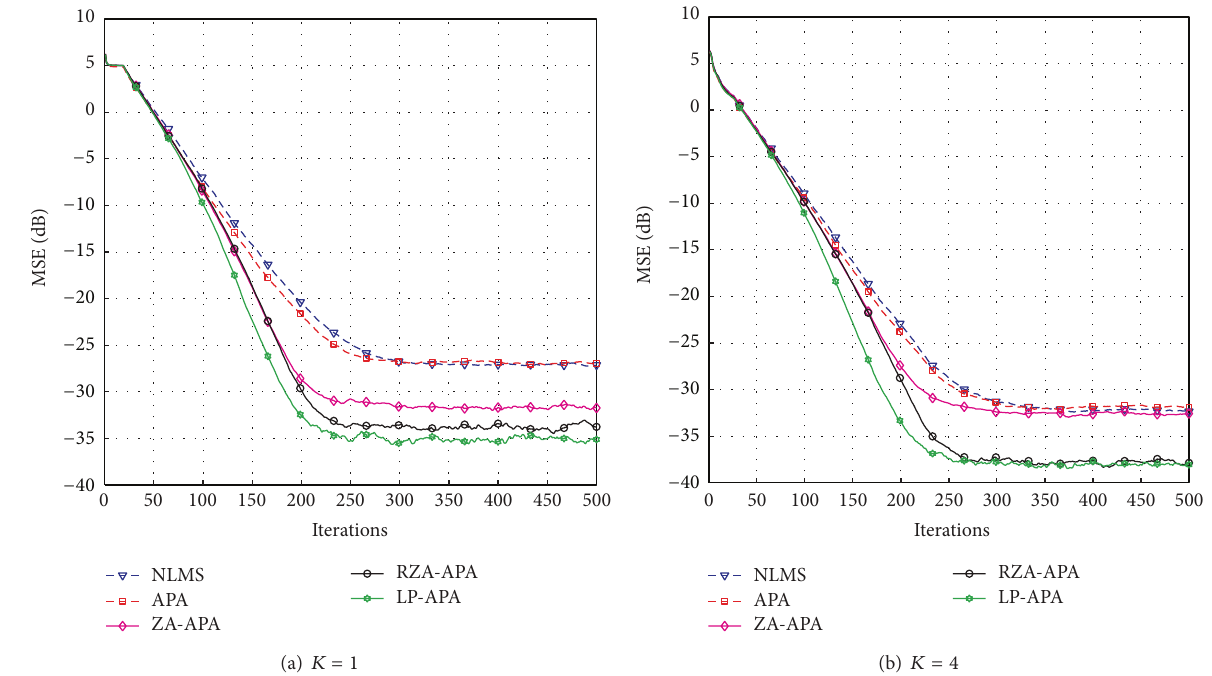
Figure 6: Performance of sparse channel estimation with different sparsity